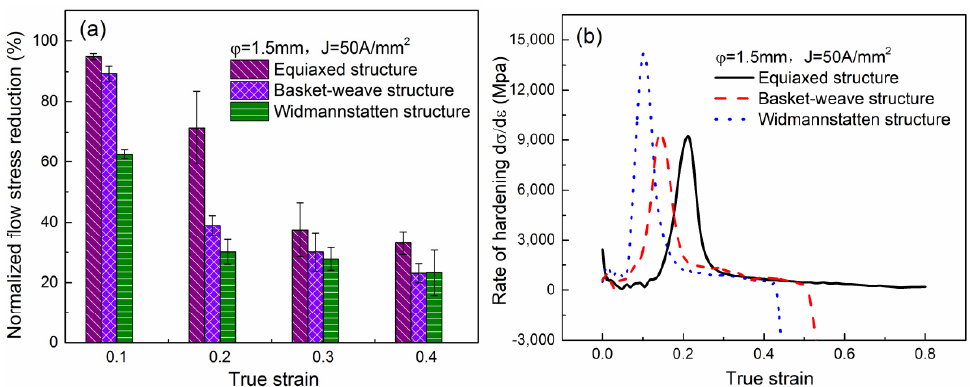
Figure 12. ( a ) Normalized flow stress reduction with different strain and ( b ) the relationship be- tween strain hardening rate and strain under 50 A/mm 2 for different initial microstructure speci- mens.